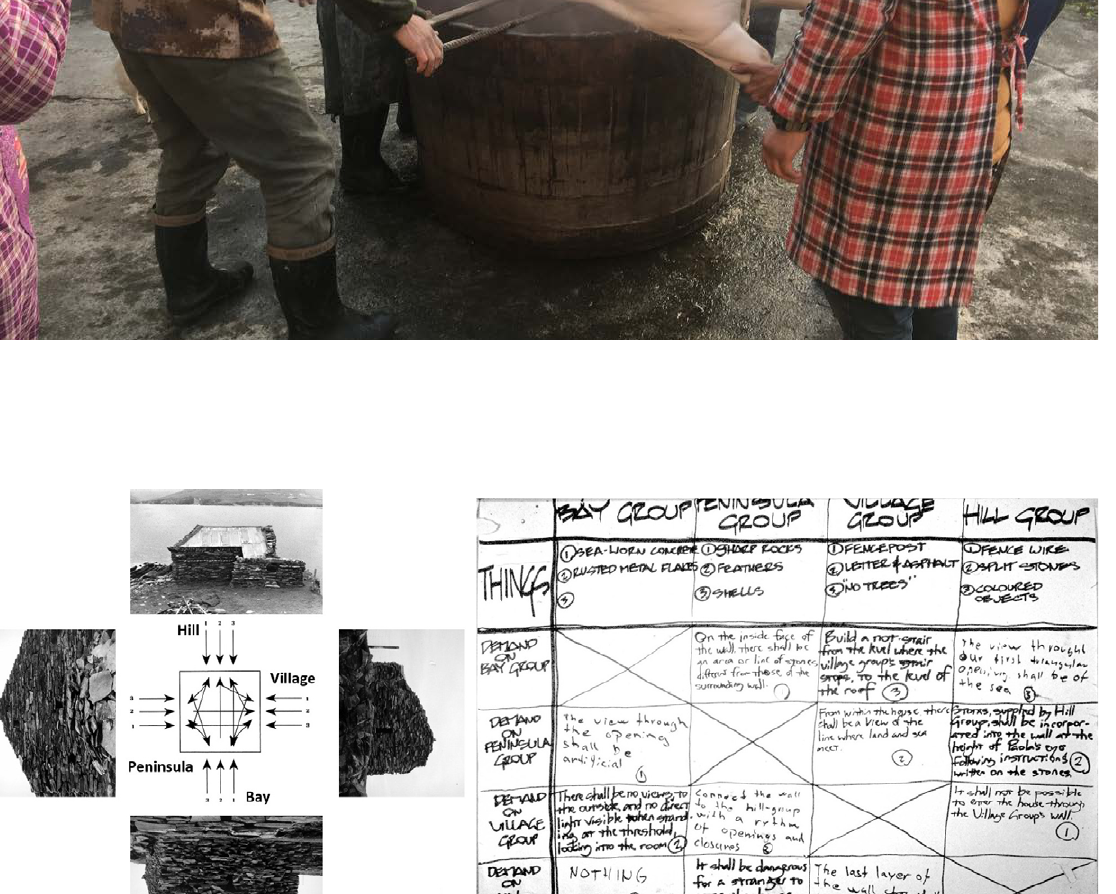
Figure 1 (this page, top): In both Miaoxia community projects, a pig “thing” was slaughtered on the morning of the inauguration, carried to the village temple and then to the buildings, before being butchered and served up at the village feast. Source: Author. Figure 2 (this page, bottom): Stonehouse schema and list of things and demands. Source: Author. Figure 3 (pages 157, top): Miaoxia community kitchen built